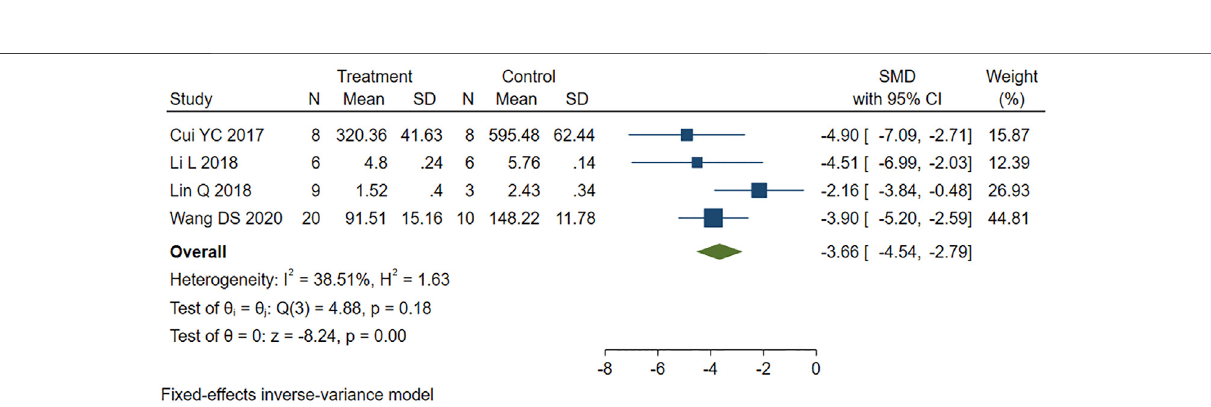
Frontiers in Pharmacology |